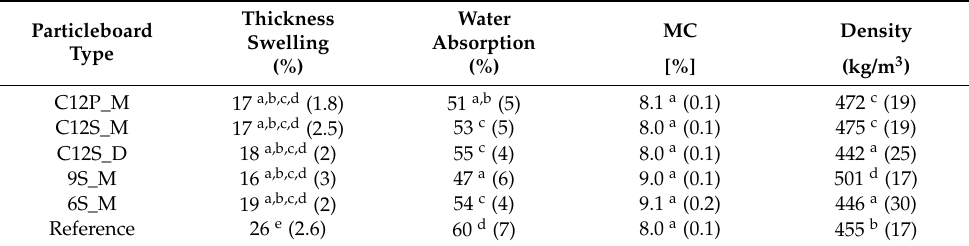
Table 2. Thickness swelling and water absorption after 24 h of the 10 mm particleboards with PS (values with the same letter (a, b, c, d, e) are not significantly different ANOVA, Post-Hoc Tukey HSD, p = 0.05; standard deviation in